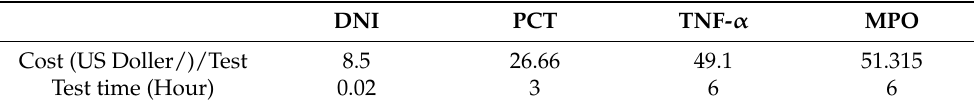
Table 3. Cost-effectiveness between sepsis